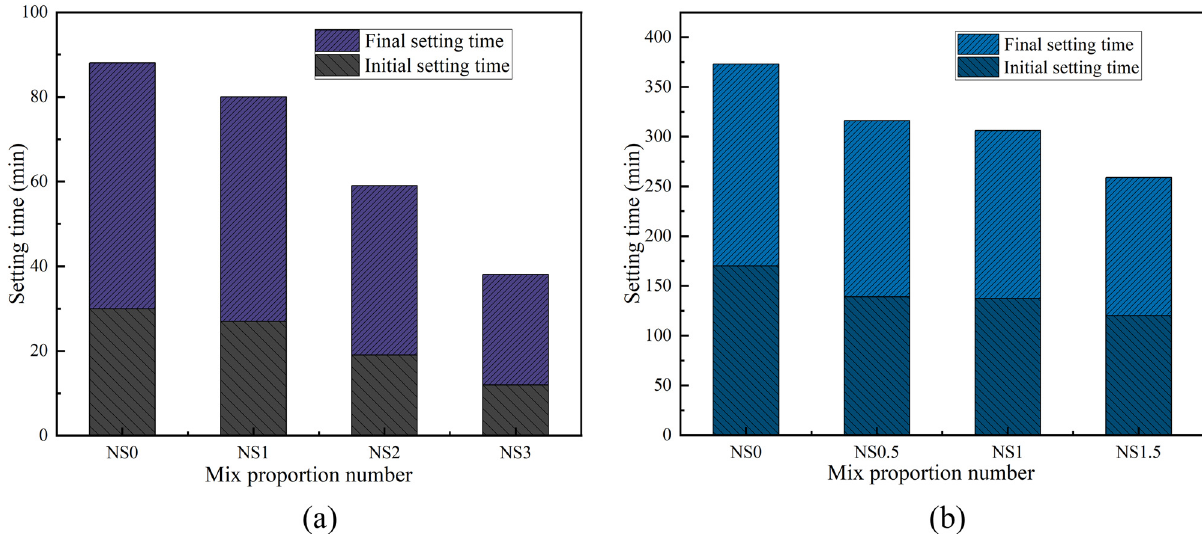
Figure 14: E ff ect of nano - SiO 2 on the setting time of fl y ash - based geopolymers. ( a ) High - calcium fl y ash - based geopolymer [ 38 ] . ( b ) Low - calcium fl y ash - based geopolymer [ 41 ] .